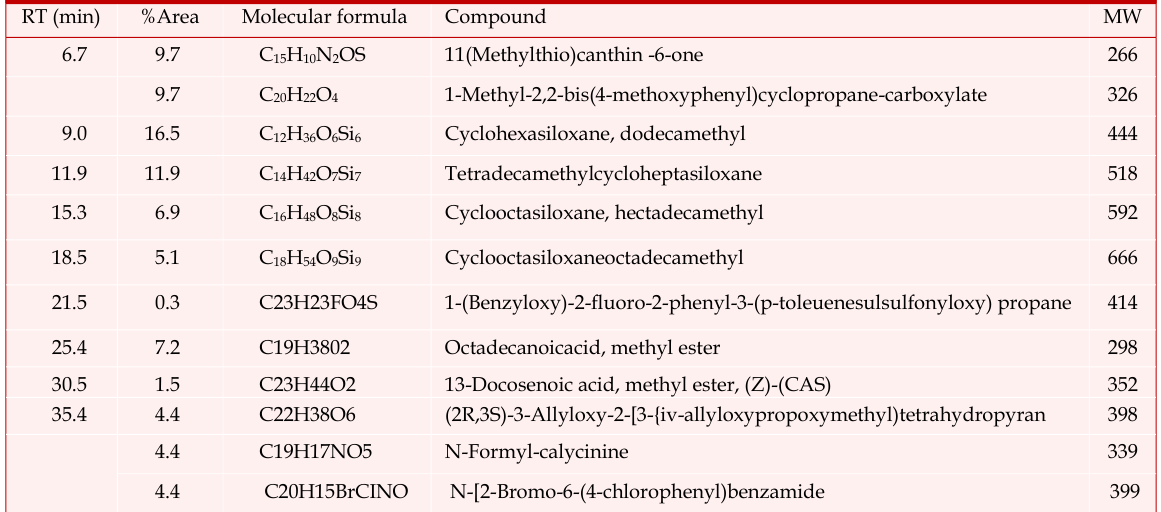
Chemical profile identified by GC-MS analysis of methanol root extract of TLC separated band 5